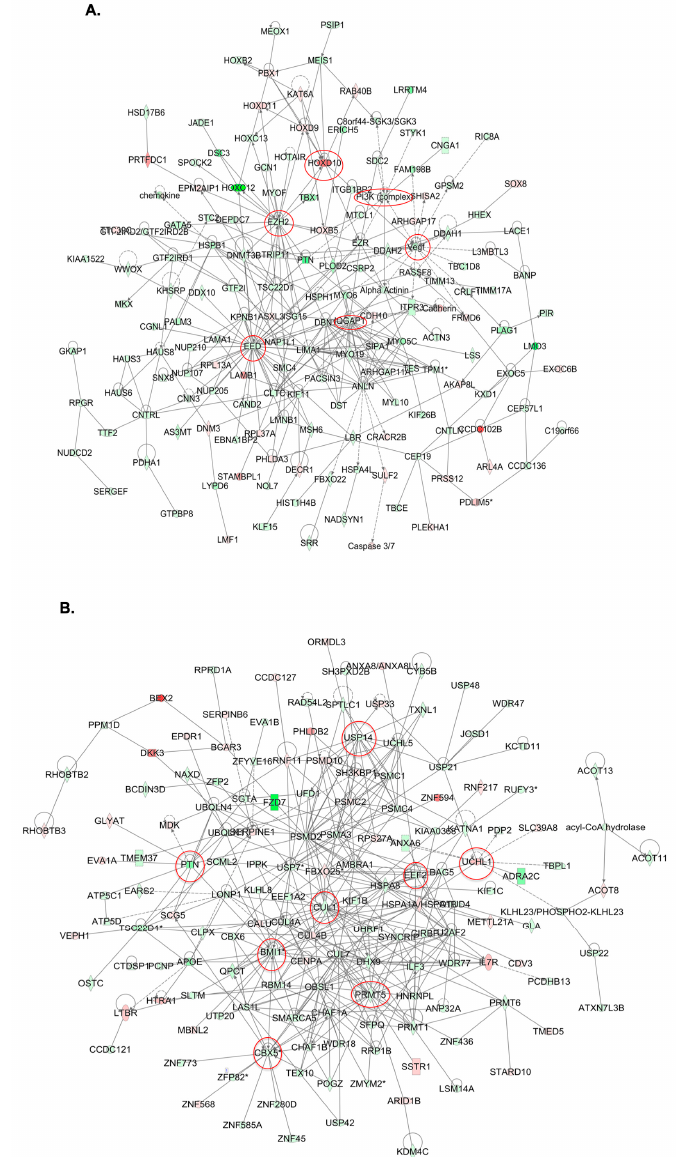
Figure 5. Dynamic gene expression analysis in A2780s cells following both GALNT3 KO and GALNT3 / T6 double KO. ( A ) Network analysis of dynamic gene expression in A2780s cells based on the 1.5-fold gene expression list obtained following GALNT3 KO. The five top-scoring networks of up- and downregulated genes were merged and are displayed graphically as nodes (genes / gene products) and edges (the biological relationships between the nodes). ( B ) Network analysis of dynamic gene expression in A2780s cells based on the 1.5-fold gene expression list obtained following GALNT3 / T6 double KO. The five top-scoring networks of up- and downregulated genes were merged and are displayed graphically as nodes (genes / gene products) and edges (the biological relationships between the nodes). Intensity of node color indicates the degree of upregulation (red) or downregulation (green). Nodes are displayed using various shapes that represent the functional class of the gene product (square, cytokine, vertical oval, transmembrane receptor, rectangle, nuclear receptor, diamond, enzyme, rhomboid, transporter, hexagon, translation factor, horizontal oval, transcription factor, circle, etc.). Edges are displayed with various labels that describe the nature of the relationship between the nodes: __ binding only, → acts on. Dotted edges represent indirect interaction. Circled nodes in red represent the major gene nodes examined in this